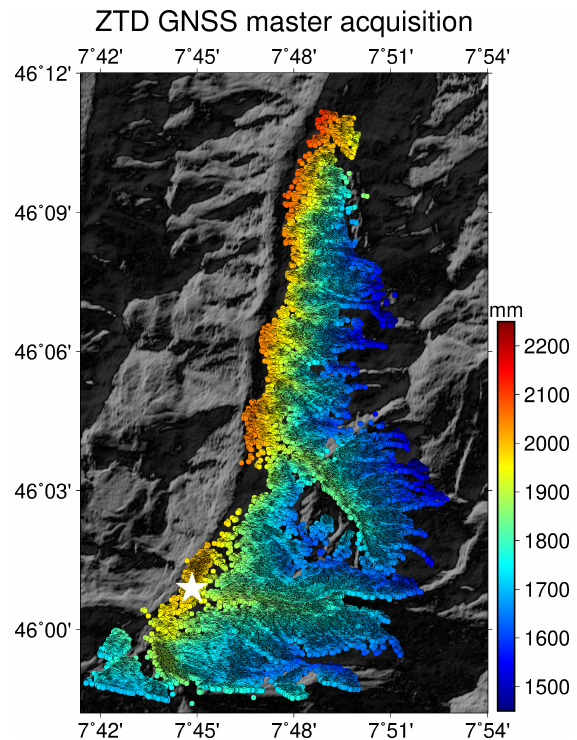
Figure 6. The example of ZTD s calculated for all 326,552 PS for master acquisition (20 September 2010, T:17:46:45) superimposed with GDEM. The white star indicates the reference